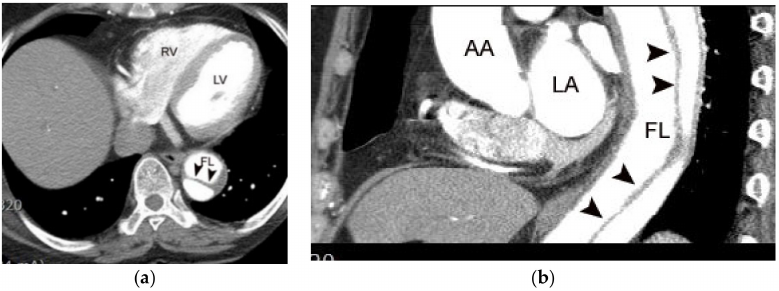
Figure 12. A case of type B aortic dissection identified on coronary CTA. Note the intimal flap within the descending thoracic aorta (arrowheads in ( a , b )) RV, LA, LV, AA, FL indicate right ventricle, left atrium, left ventricle, ascending aorta, and false lumen, respectively.